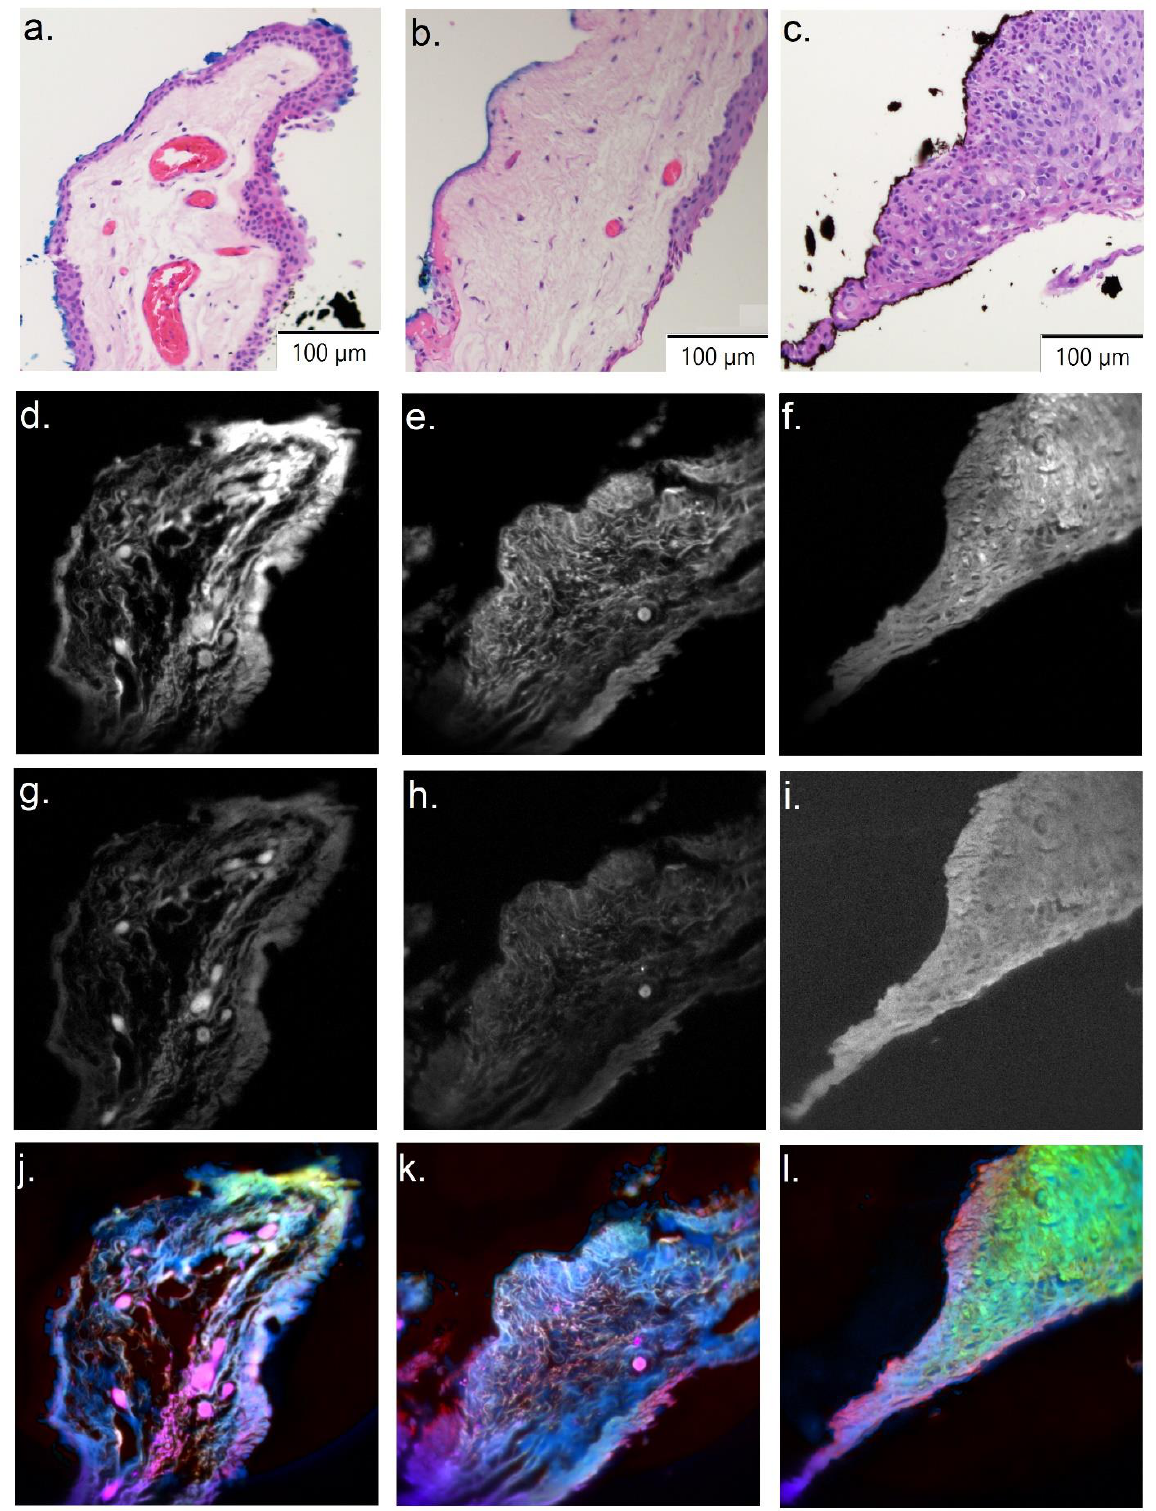
Figure 4. Spectral differences between normal, PTG, and OSSN. ( a – c ) H&E image for normal, PTG, and OSSN sections, respectively. ( d – f / g – i ) Channel 1/Channel 20 for normal, PTG, and OSSN sections, respectively. ( j – l ) PCA false color image for normal, PTG, and OSSN sections respectively. OSSN is green, while normal and PTG are